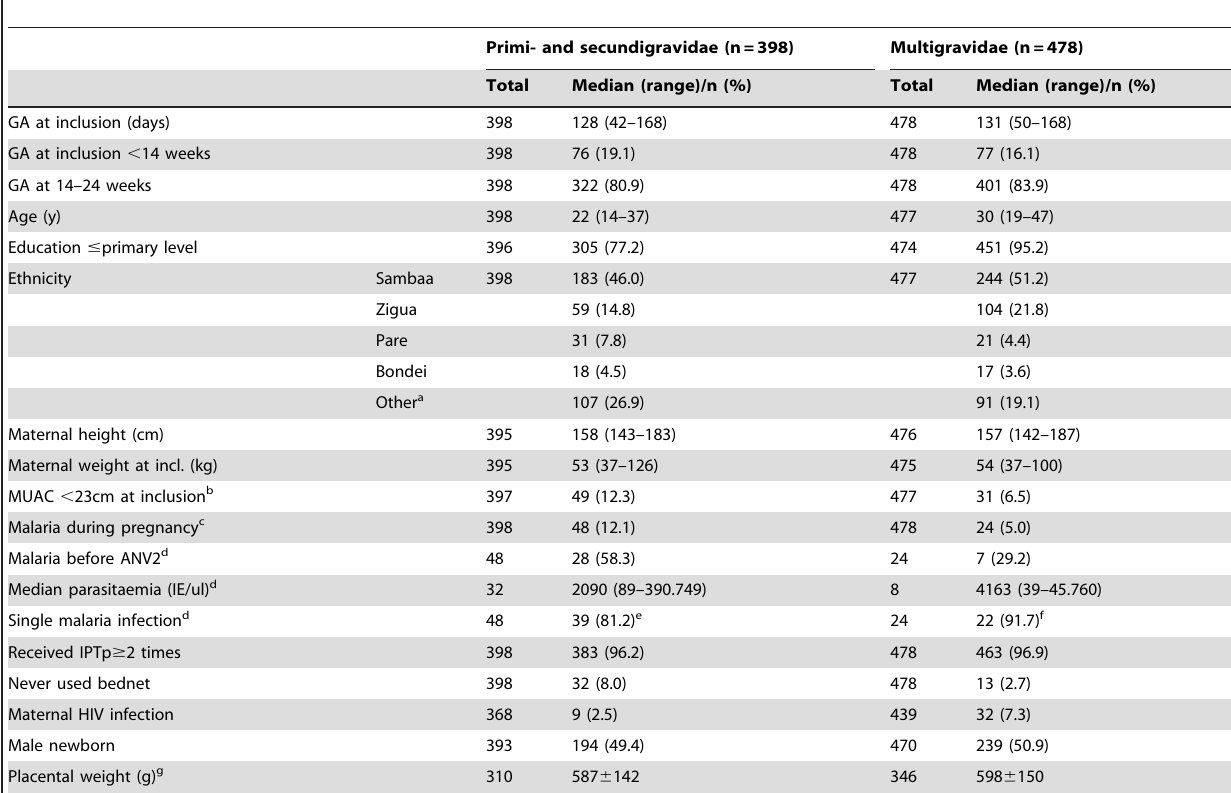
Table 1. Characteristics of the 876 mother-newborn pairs eligible for analysis stratified by